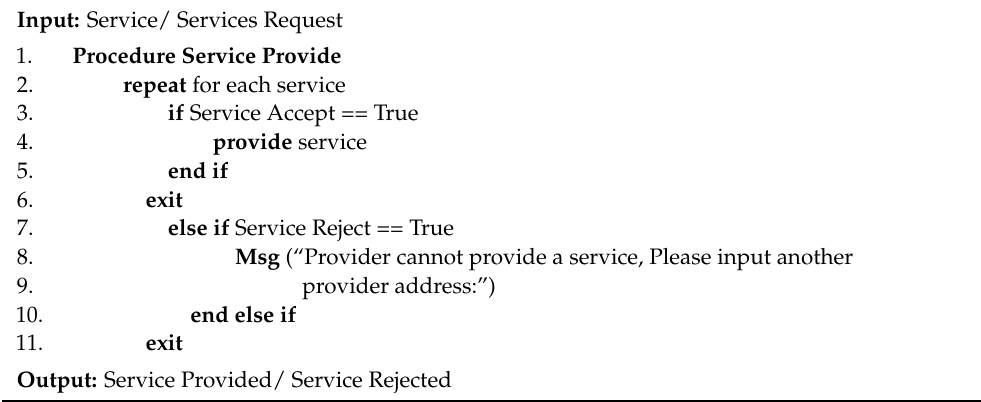
Algorithm A3 Algorithm for Providing Service/Services